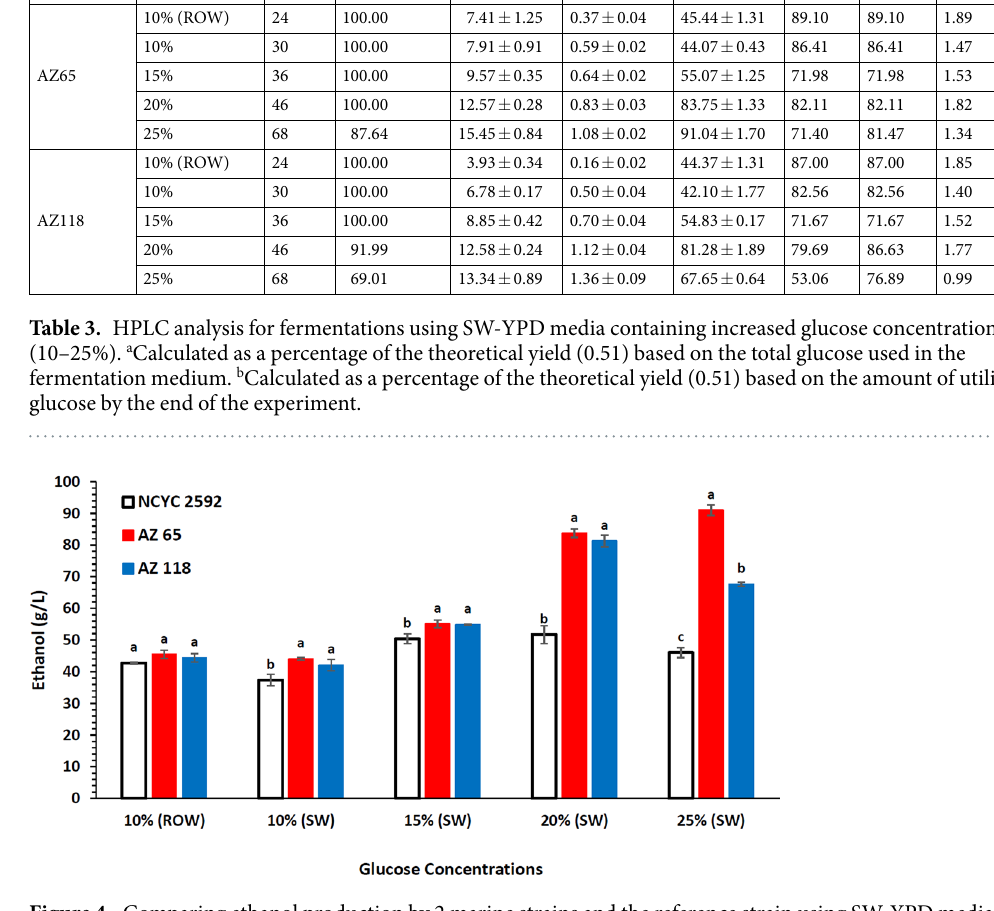
Figure 4. Comparing ethanol production by 2 marine strains and the reference strain using SW-YPD media containing increased glucose concentrations (10, 15, 20, 25%) dissolved in seawater. a,b,c Columns bearing different superscript in the same treatment differ significantly (p < 0.05). The experimental error bars represent the standard deviation of the three replicates.